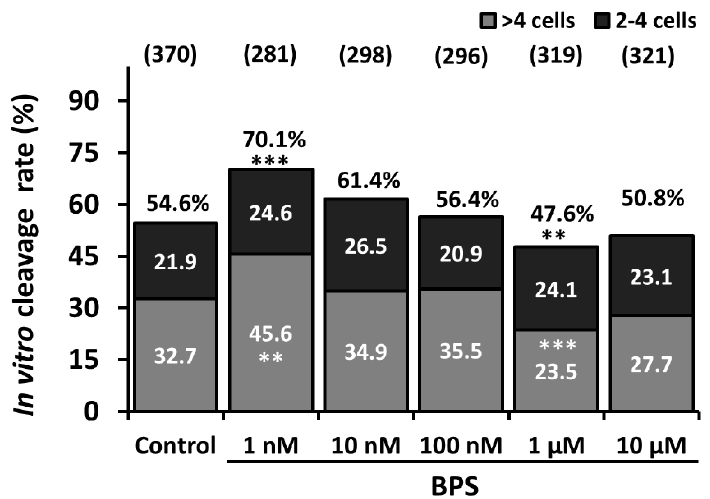
Figure 1. Effect of Bisphenol S (BPS) during in vitro maturation (IVM) on the cleavage rate. Oocytes underwent IVM in the presence or absence of BPS (1 nM, 10 nM, 100 nM, 1 µM or 10 µM). Oocytes were then subjected to in vitro fertilisation (IVF), and the cleavage rate was assessed 2 days after IVF. Embryos with more than four cells were distinguished among mature and fertilised cumulus oocyte complex (COCs). The percentage of cleaved embryos was normalised to the total number of oocytes that underwent IVF. The results from eight independent experiments are expressed as the raw percentage of embryos at each developmental stage. ** indicates a significant difference for a given stage compared with the control ( p ≤ 0.01). *** indicates a significant difference for a given stage compared with the control ( p ≤ 0.001). Total numbers of mature and fertilised COCs per group are indicated between parentheses.